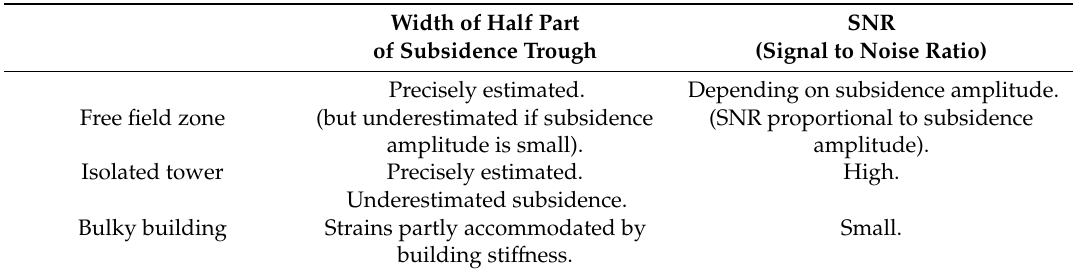
Table 1. Signal-to-noise ratio (SNR) for the recorded subsidence at various cases of the surface above